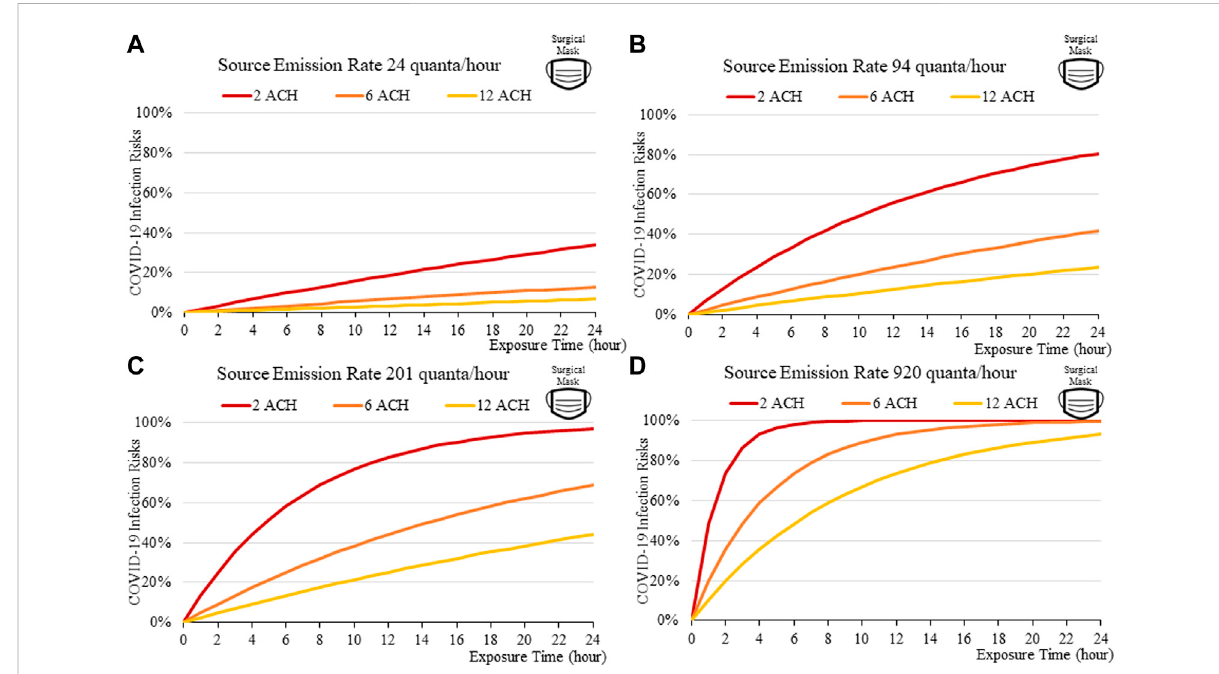
Disease infection risks for the Omicron variant, assuming the receiver and index patient are both wearing surgical face mask (55% and 75% Inward and Outward Filtration Ef fi ciencies): Assuming the exhale quanta emission rate of 24 (A) , 94 (B) , 201 (C) , and 920 (D) quanta/hour for the Source.